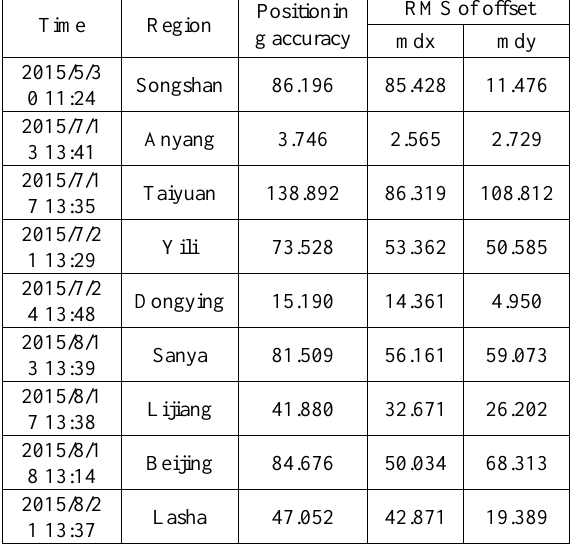
Table 1. Tables of geometric accuracy of panchromatic image when low frequency error compensation model is not added (Unit: